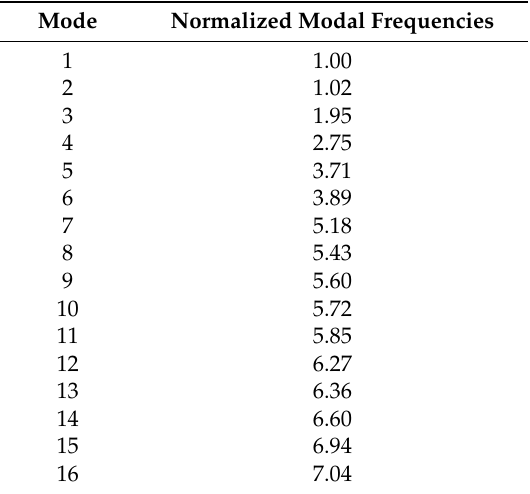
Table 2. Numerical normalized modal frequencies.